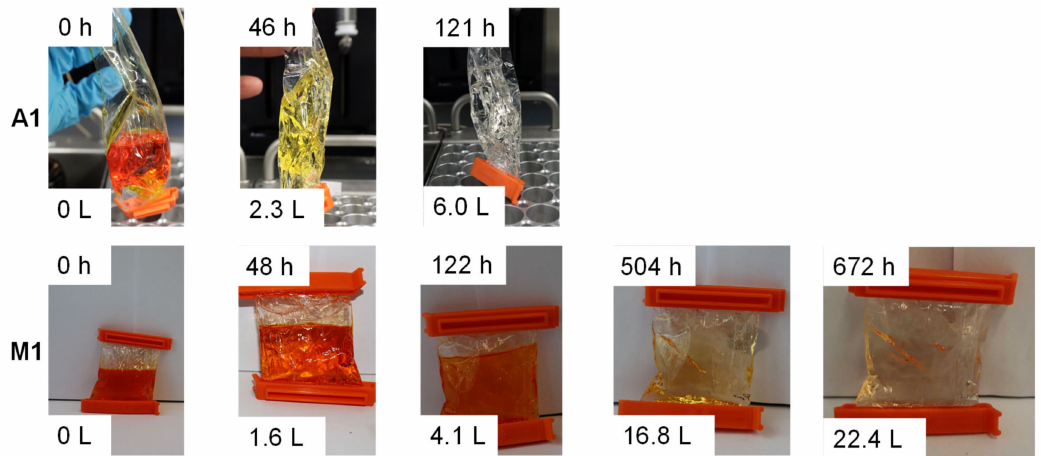
Figure 2. Time-dependent analysis of the dialysis of P3 and Sudan I mixture (automated dialysis modus 1 top; manual dialysis